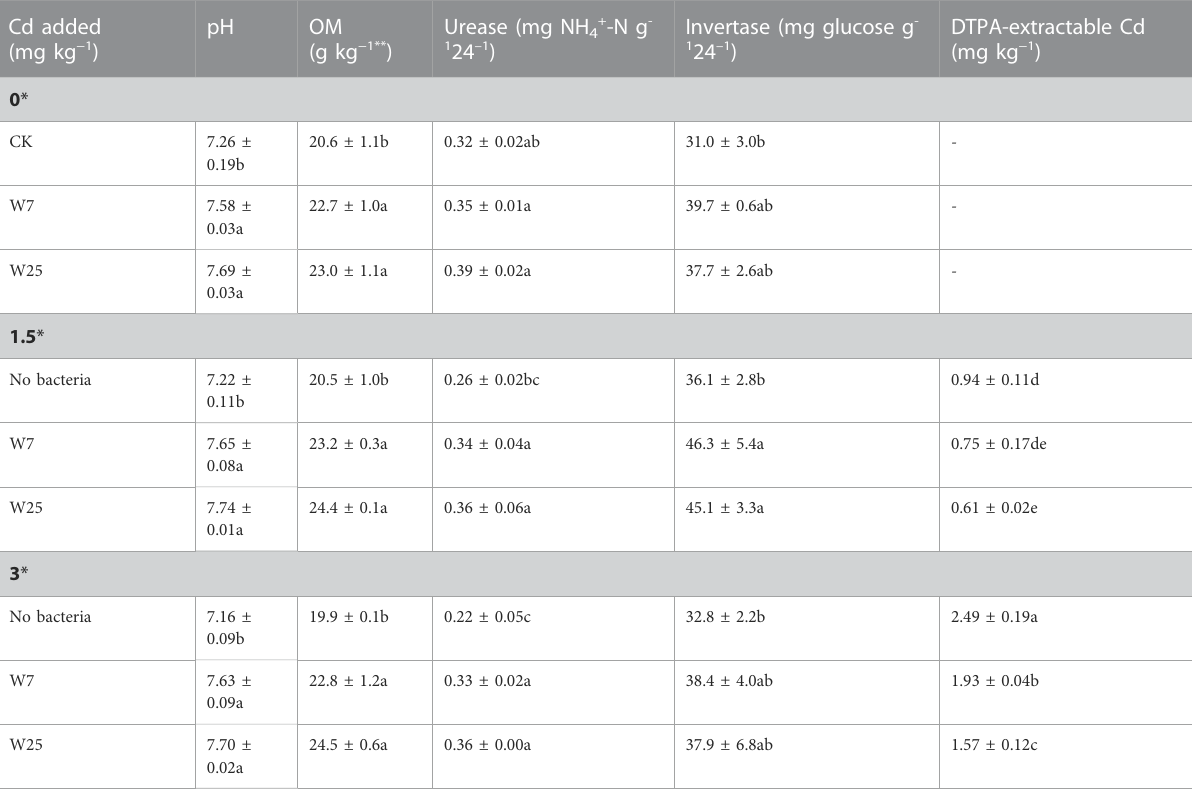
TABLE1EffectsofstrainsW7andW25onthepH,organicmattercontent,enzymeactivitiesandDTPA-extractableCdcontentoftherhizospheresoilsofwheat plants. The values are means ± standard error ( n = 3). Mean followed by the same letters within the same column are not signi fi cantly different ( p > 0.05) according to Tukey ’ s test. **OM: organic